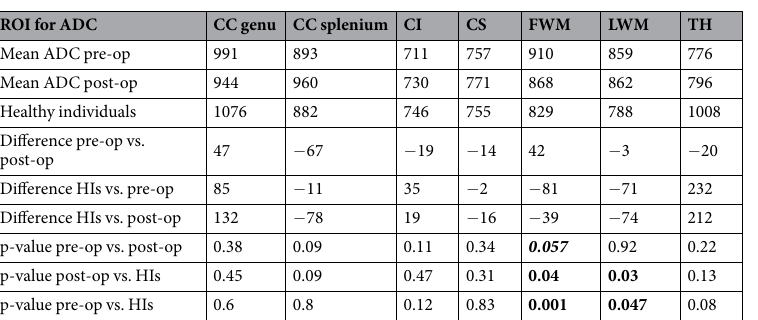
Table 4. ADC values of pre- and post-operative patients and HIs, with statistical analysis. pre-op: pre-operative patients; post-op: post-operative